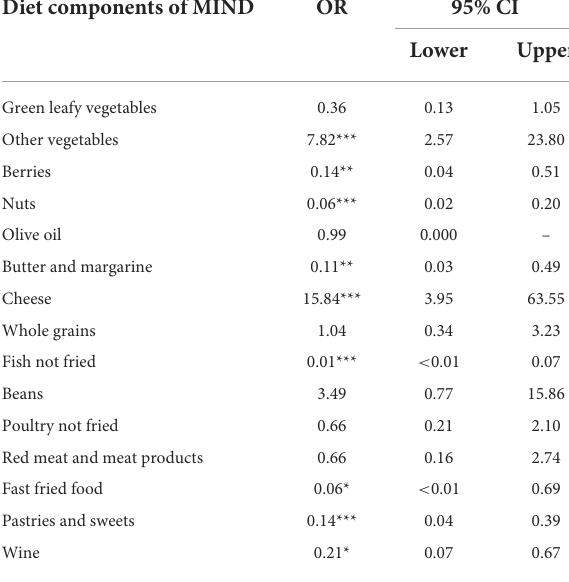
TABLE 2 Odds ratios (OR) and Confidence intervals 95% (CI) of all MIND diet components from nine separate logistic regression analyses controlling for gender, age, BMI and DASS-21 affecting patient and healthy control groups separation. Diet components of MIND